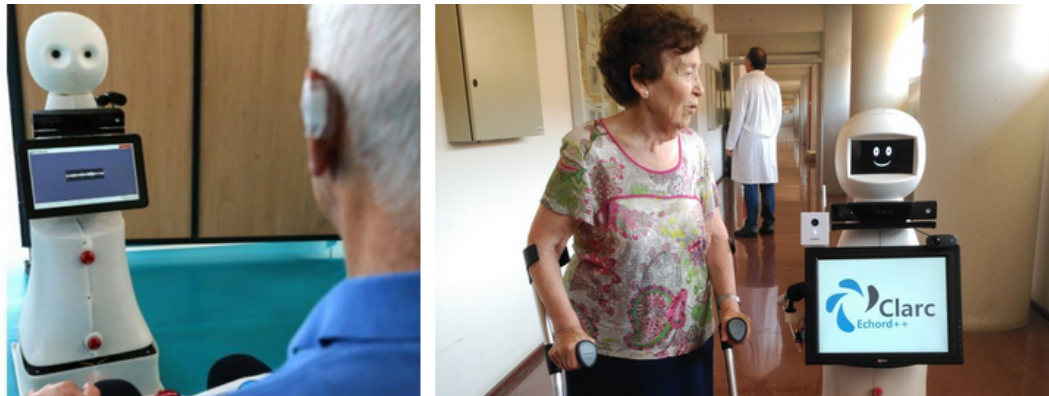
Figure 8. The CLARC robot interacting with elderly people. ( Left ) The final version deployed in Reims; and ( Right ) The first version of the robot, which was one of the platforms tested in Seville.